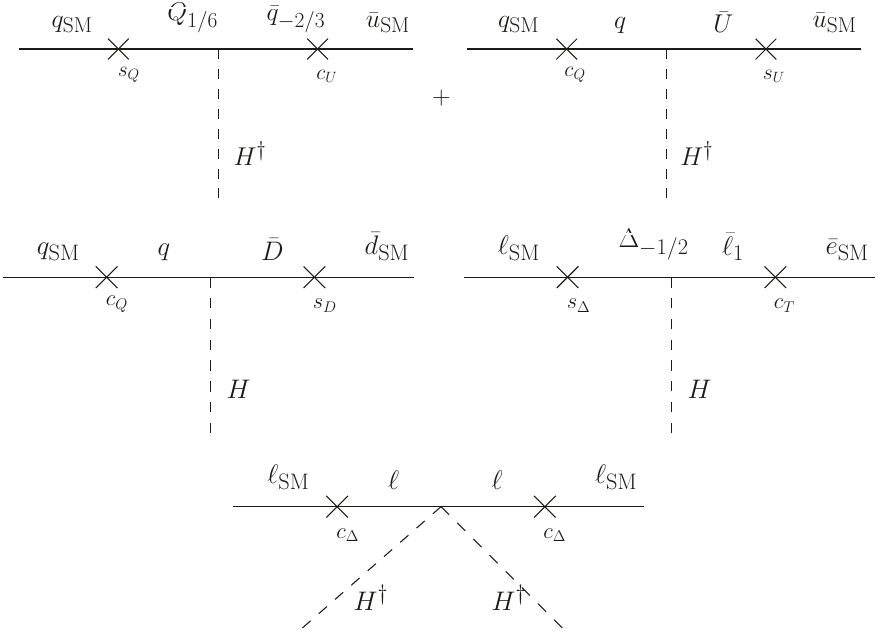
q m 2 + x 2 v 0 2 X X